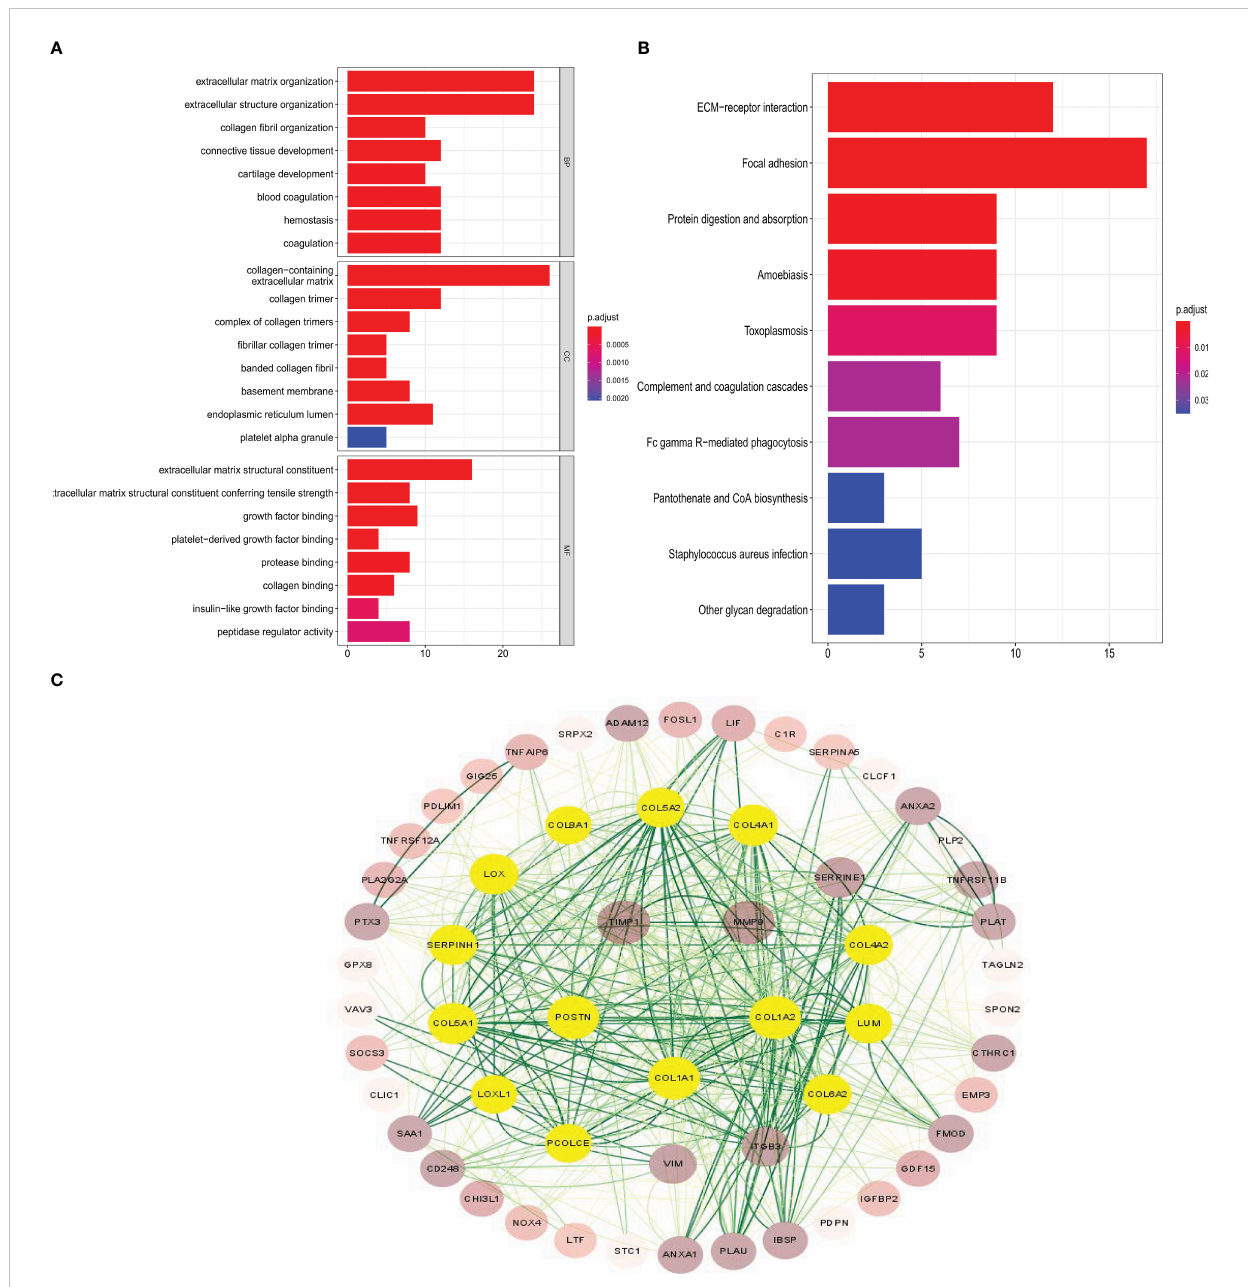
FIGURE 3 GO, KEGG, and protein – protein interaction network analysis in the common genes. (A, B) GO enrichment analysis and KEGG pathway analysis show the common genes participating in in fi ltration. (C) The most signi fi cant genes are based on the protein – protein interaction network in the common